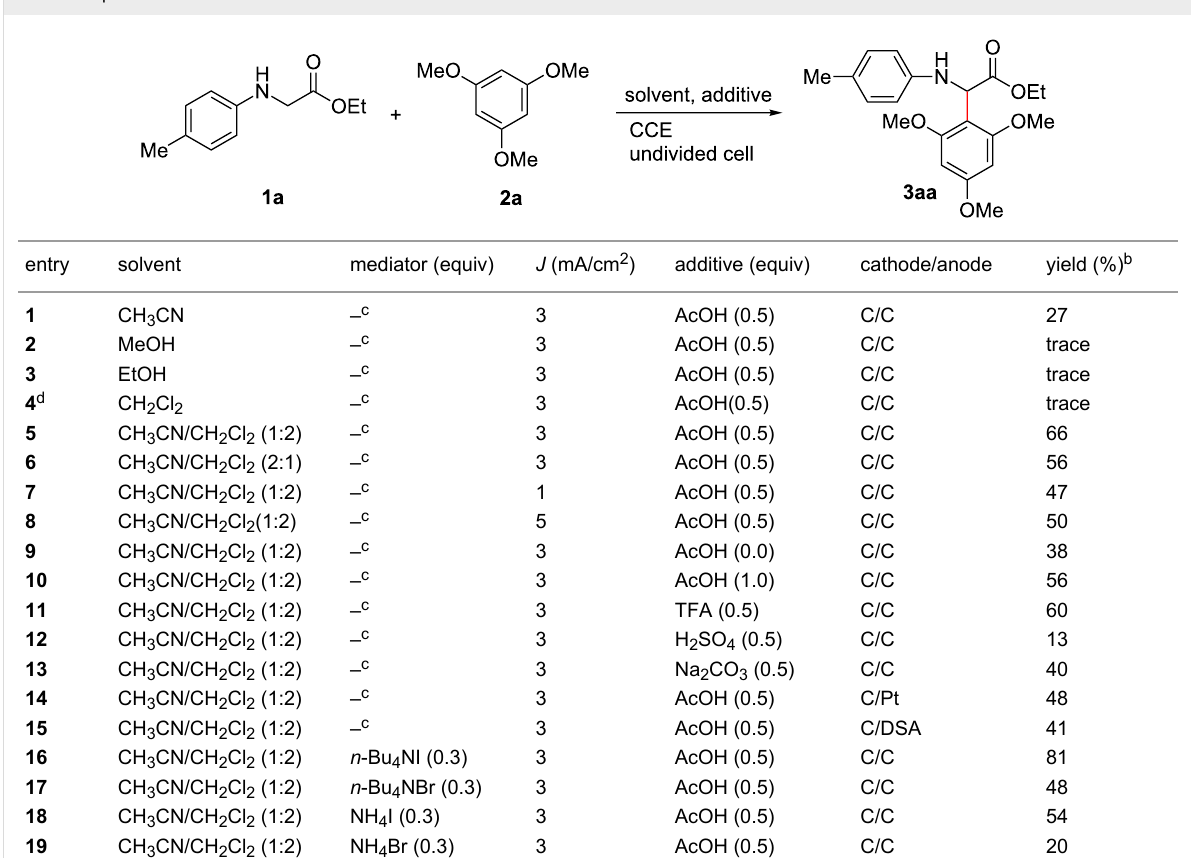
Table 1: Optimization of reaction conditions a